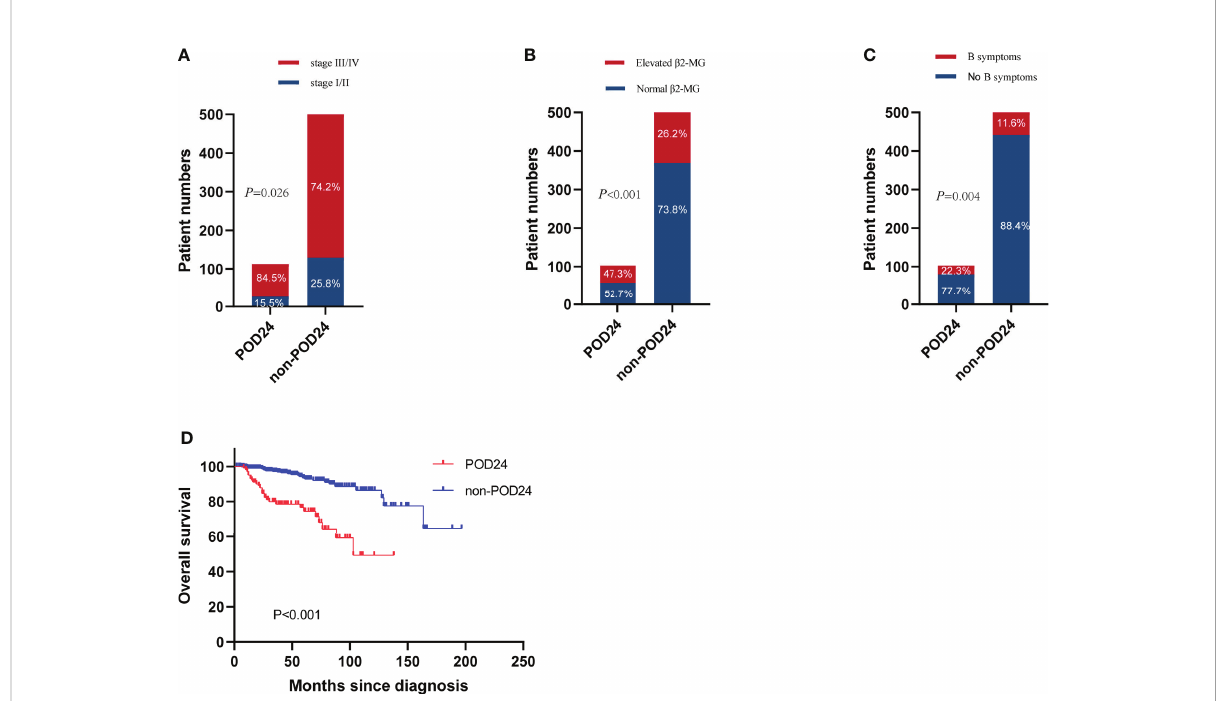
FIGURE 5 Incidence of POD24 in three states. (A) Stage III – IV, (B) elevated b 2-MG, and (C) B symptoms. (D) OS for patients with or without